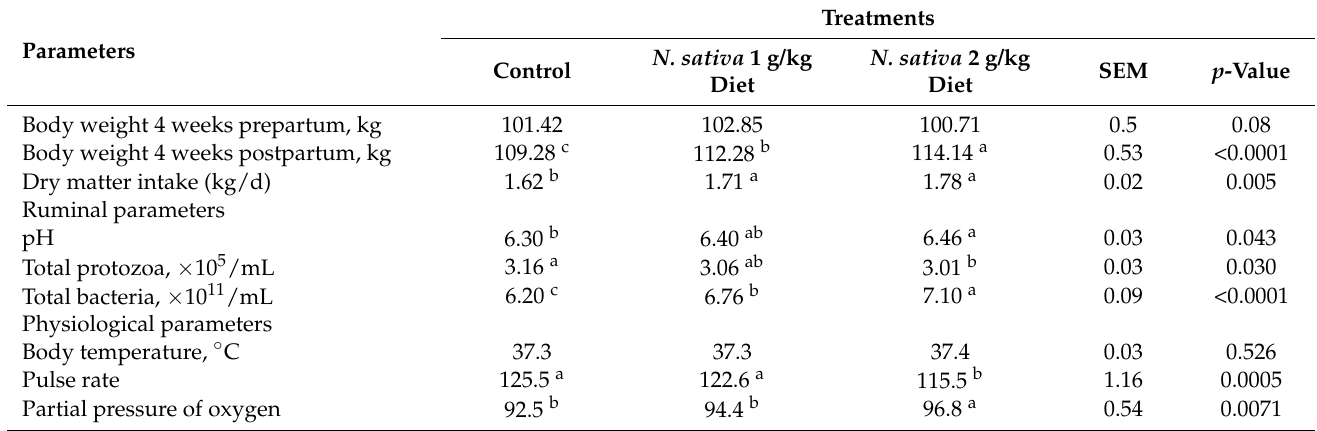
Table 2. Effects of N. sativa (10.0 and 20 g/kg diet) on body weight, ruminal, and physiological parameters of Ardi goats in subtropics.